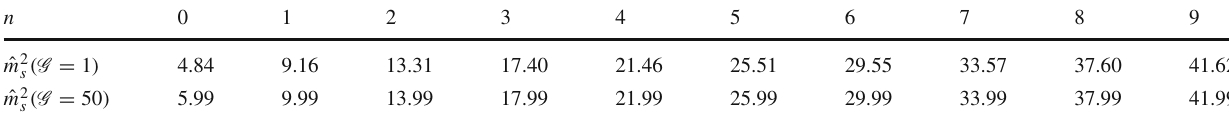
Table 1 The mass spectrum of scalar mesons at zero temperature for two different values of the dimensionless parameter G . The masses are dimensionless